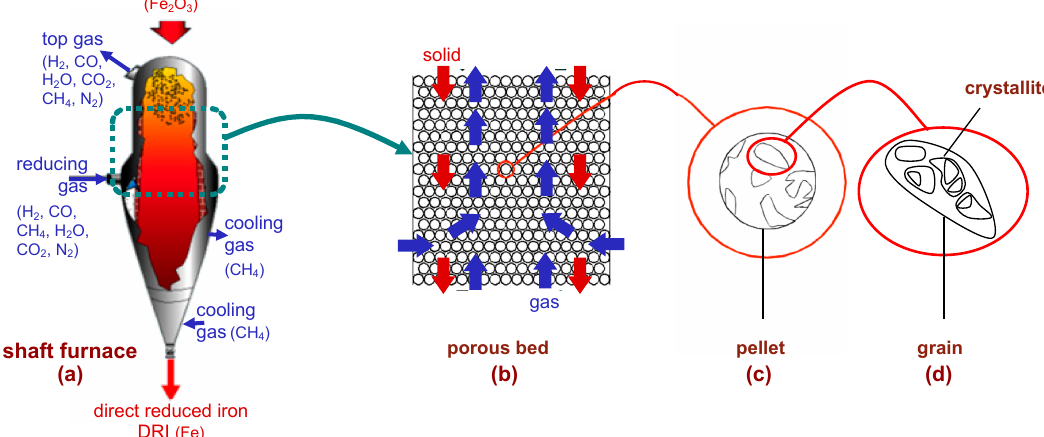
Figure 2. Principle of the REDUCTOR (v1) model; ( a–d ): the four scales considered.